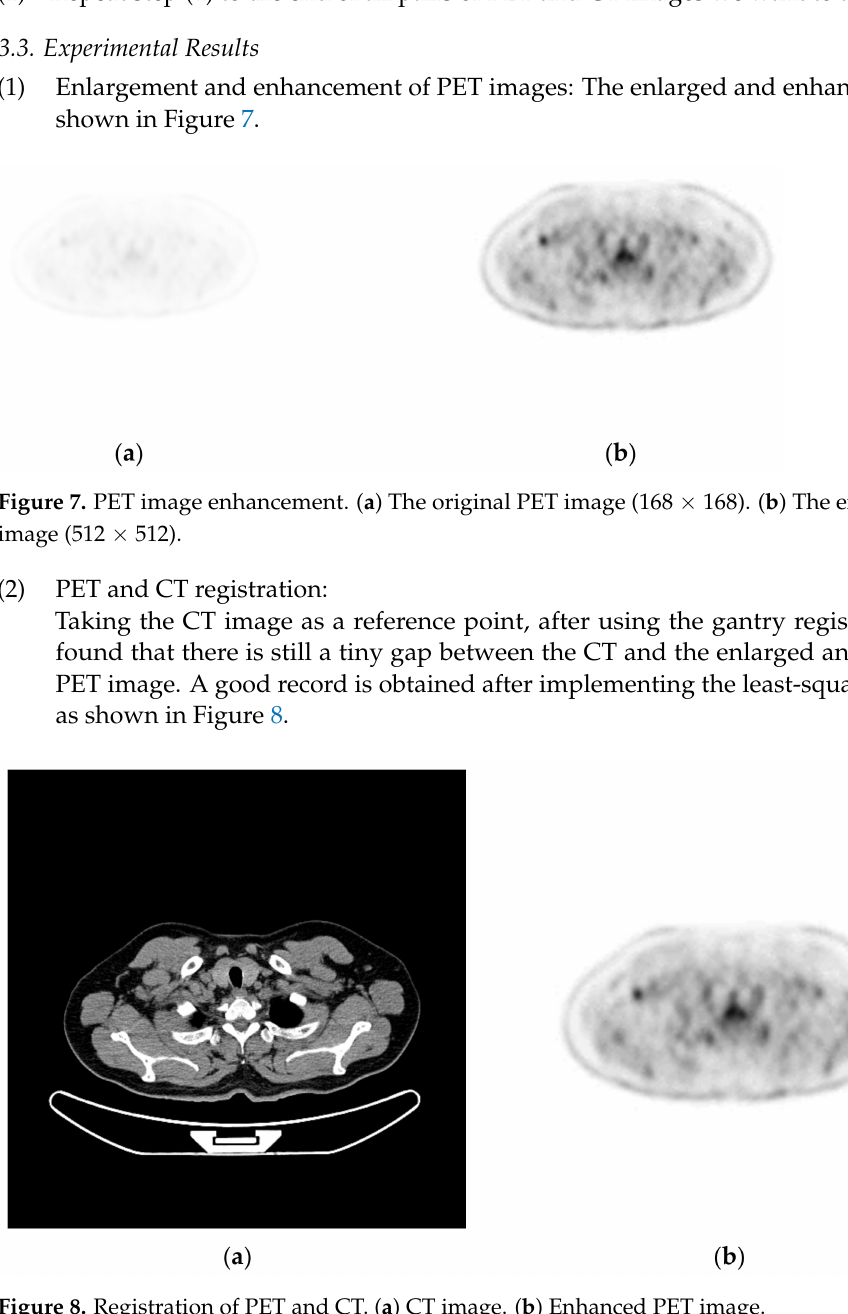
Figure 8. Registration of PET and CT. ( a ) CT image. ( b ) Enhanced PET